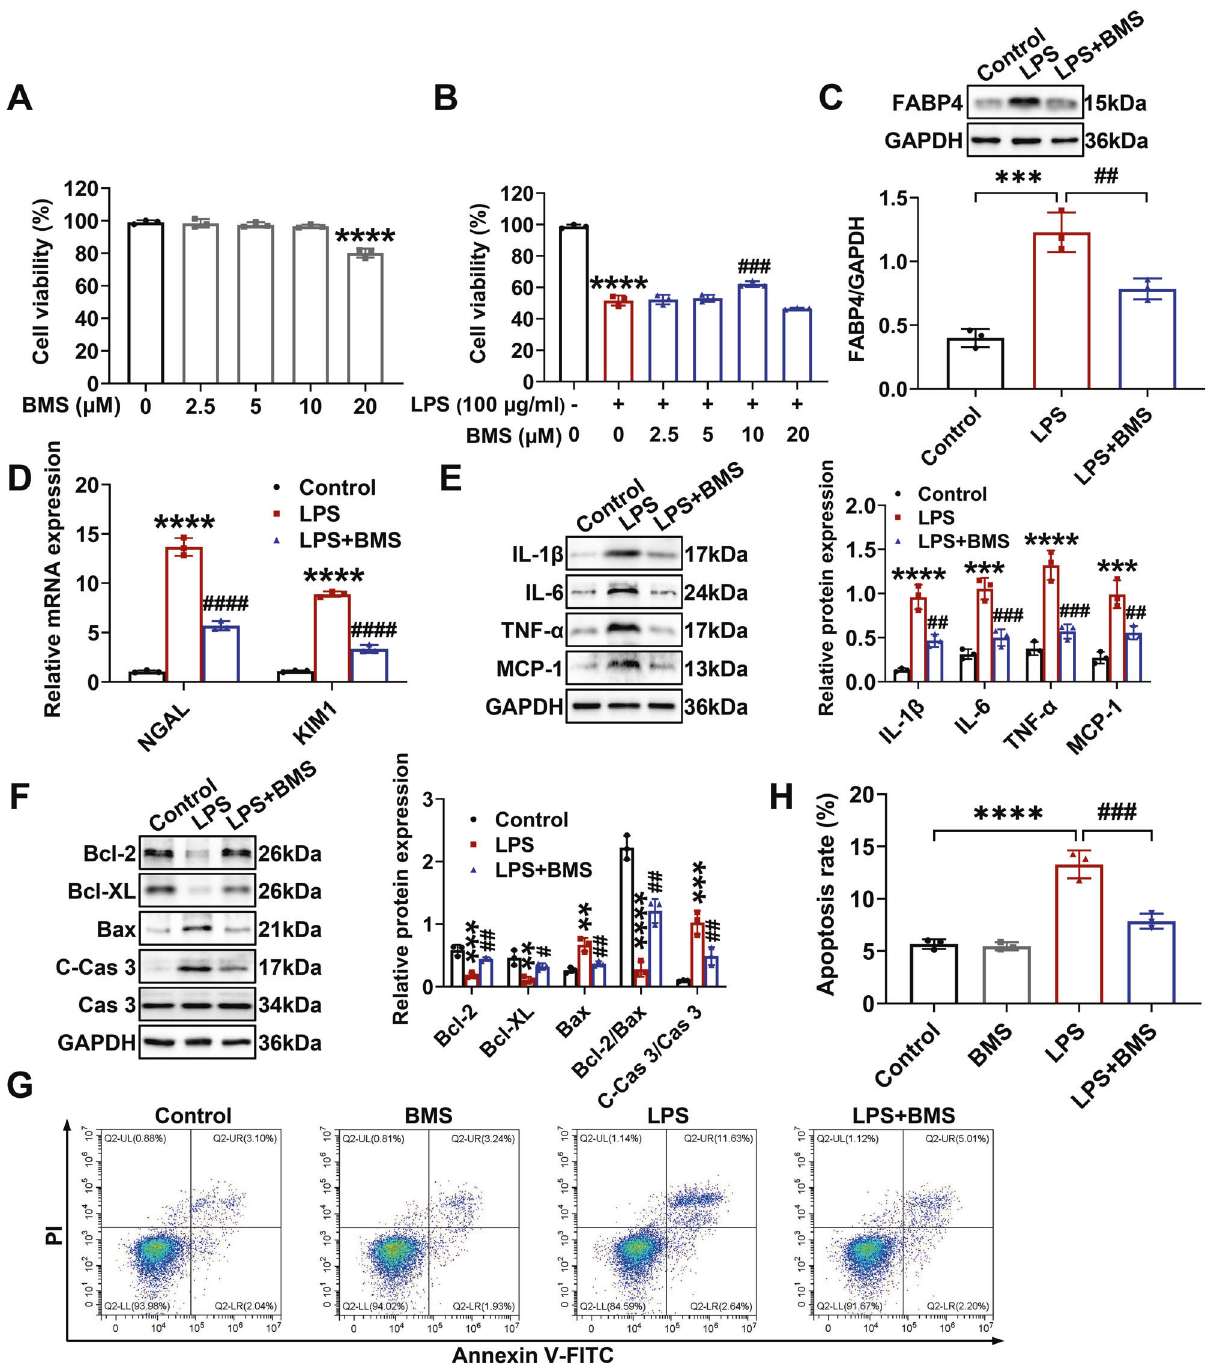
Fig. 6 FABP4 inhibitor BMS309403 treatment suppressed in fl ammation and apoptosis in LPS-stimulated TCMK-1 cells. TCMK-1 cells were either untreated or pretreated with BMS309403 (BMS) for 30 min before 24 h of 100 μ g/ml LPS stimulation. A The cytotoxic effect of BMS (0, 2.5, 5, 10, and 20 μ M) on TCMK-1 cells for 24 h determined by Cell Counting Kit-8 assay (mean ± SD, n = 3). **** P < 0.0001 versus BMS ( μ M) 0 group. B The cytoprotective effect of BMS (0, 2.5, 5, 10, and 20 μ M) on LPS-stimulated TCMK-1 cells for 24 h determined by Cell Counting Kit-8 assay (mean ± SD, n = 3). **** P < 0.0001 versus BMS ( μ M) 0 with LPS (100 μ g/ml) - group; ### P < 0.001 versus BMS ( μ M) 0 with LPS (100 μ g/ml) + group. C – H 10 μ M BMS was chosen to treat LPS-stimulated TCMK-1 cells. C Western blotting and quanti fi cation by densitometry of FABP4 in TCMK-1 cells. D Quantitative real-time PCR analysis of NGAL and KIM1 in TCMK-1 cells. Representative western blots and densitometry quanti fi cation of ( E ) in fl ammatory factors including IL-1 β , IL-6, TNF- α , and MCP-1, and ( F ) apoptotic marker including Bcl-2, Bcl-XL, Bax, caspase 3 (Cas 3), and cleaved-caspase 3 (C-Cas 3) in TCMK-1 cells. G Representative fl ow cytometric plots of TCMK-1 cell apoptosis and ( H ) quanti fi cation of apoptosis rate. Data are shown as mean ± SD ( n = 3); ** P < 0.01, *** P < 0.001, **** P < 0.0001 versus Control ; # P < 0.05, ## P < 0.01, ### P < 0.001, #### P < 0.0001 versus